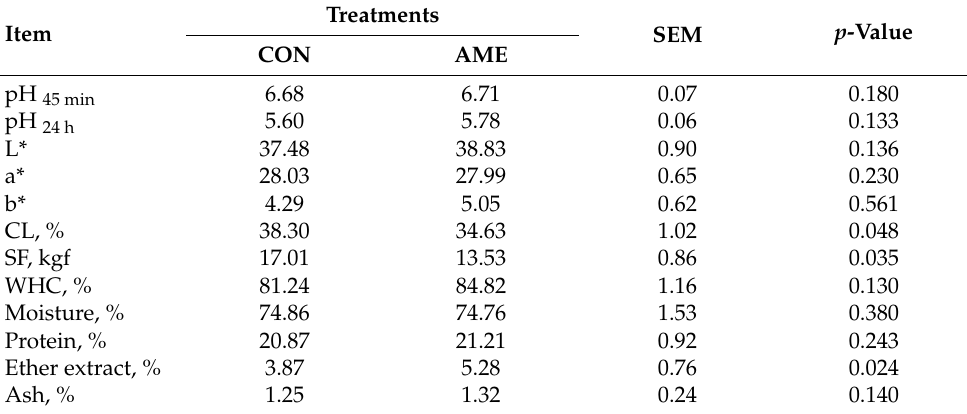
Table 3. Effect of AME on meat physicochemical characteristics of